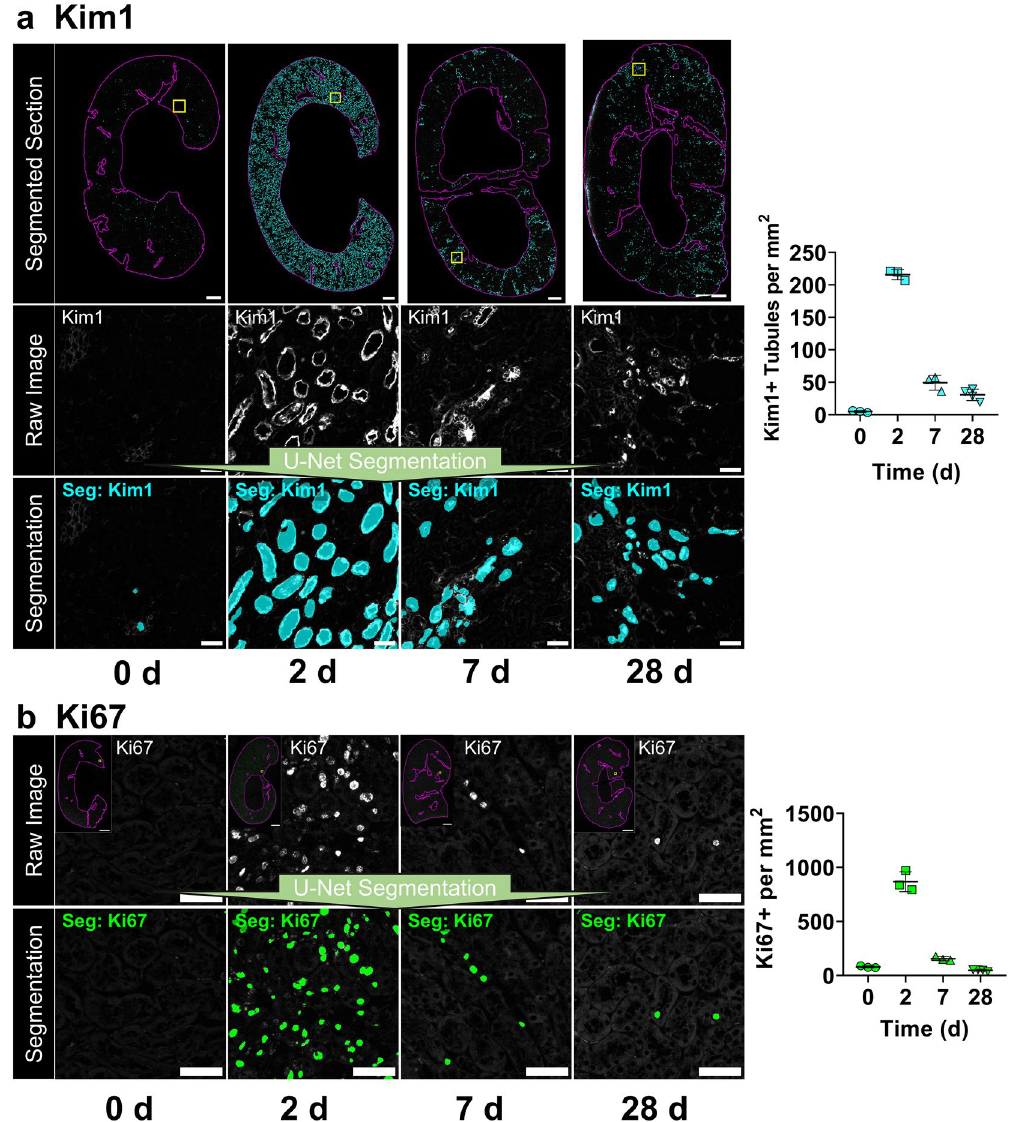
Figure 4. U-Net segmentation closely tracks the evolution of folic acid injury and identifies areas of chronic injury. ( a ) Analysis was performed over the entire cortex + OSOM (magenta outline) of coronal kidney sections obtained at various times after folic acid administration. Segmentation results were quantified as number of Kim1 + tubules per area. Representative regions (yellow box on whole-section images) are shown with the segmentation (Seg, cyan) result overlayed on the raw image (in grayscale). U-Net segmentation identified areas of persistent Kim1 expression representing areas of chronic injury 28 days after injury (28 days inset). ( b ) Overlay of Ki67 segmentation results, quantified as Ki67 + nuclei per area. For both analyses, 3–4 sections per time point were analyzed. Scale bars: 1 mm (whole kidney), 50 μm